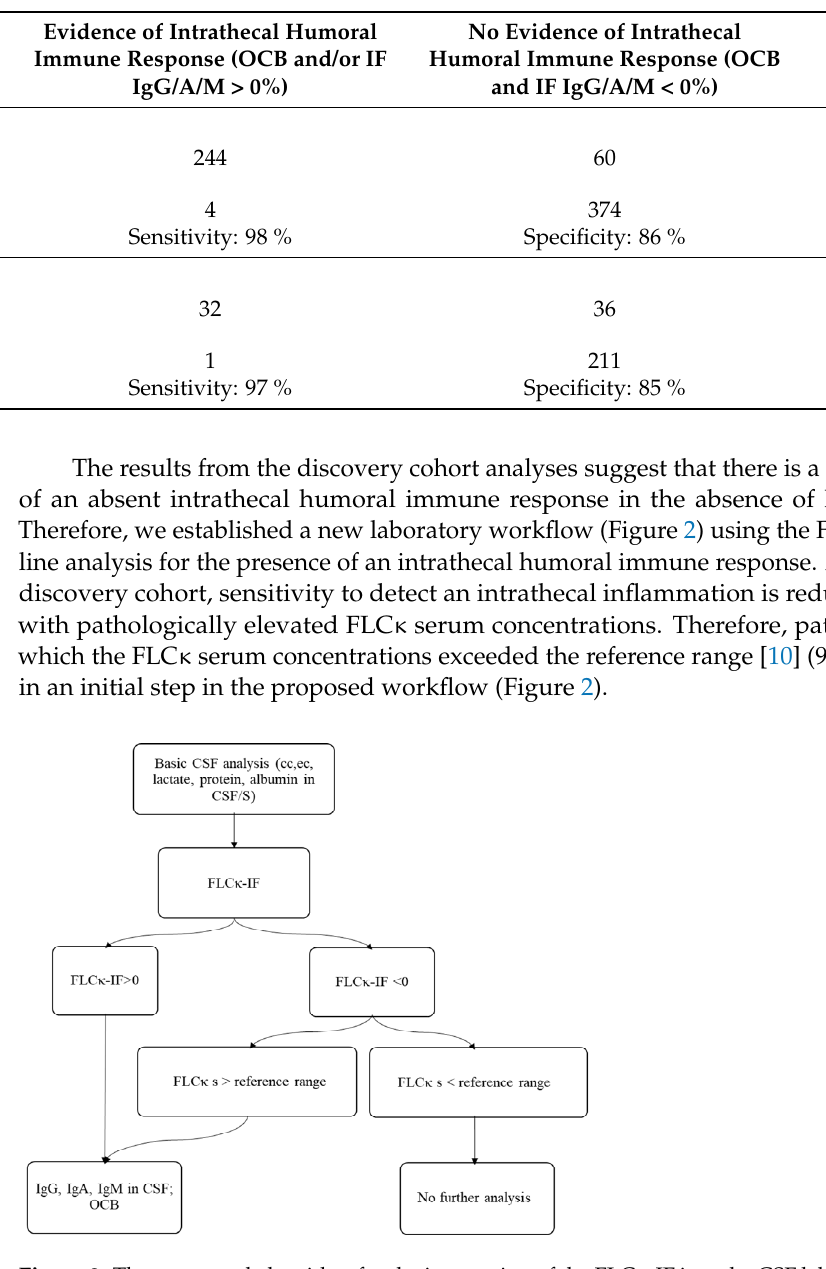
Table 2. FLC κ free light chains kappa, IF intrathecal fraction, OCB oligoclonal bands, Ig immunoglobulin.